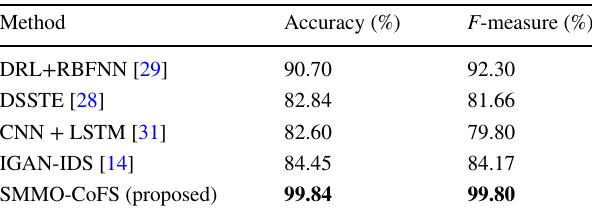
Bold values indicate the best results obtained for